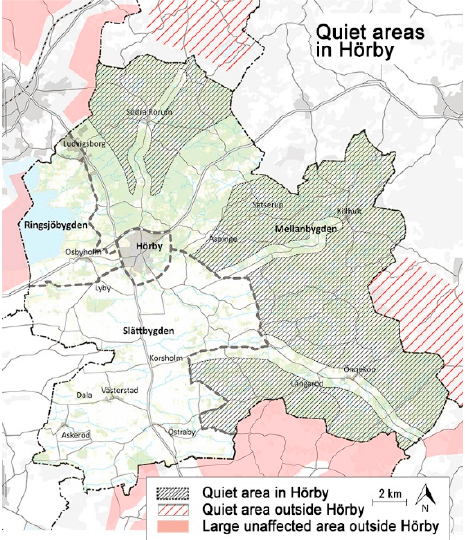
Figure 3. Map of quiet areas in the municipality of Hörby and neighboring municipalities. Adjusted and translated from